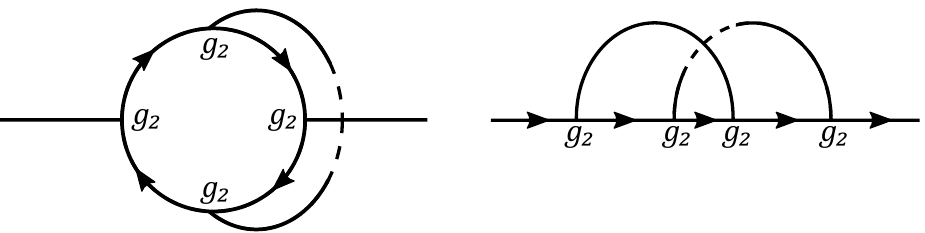
Figure 1. Representative leading nonplanar corrections to the self-energies in the noncommutative Yukawa theory of [107]. Fermion lines have arrows and dashing denotes